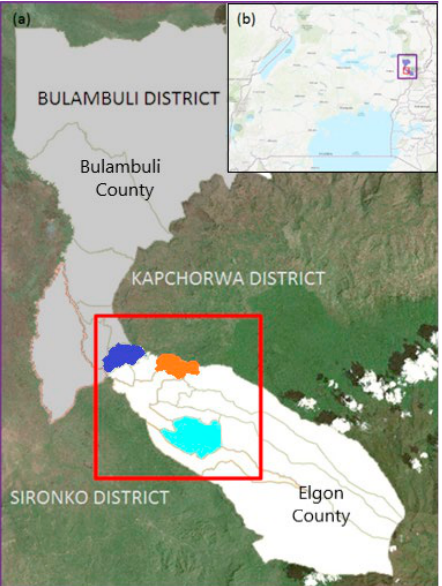
Figure 1. Map of (b) South Uganda and (a) details of Bulambuli district with Bulambuli County (grey) and Elgon County (white) with the sub-counties Bulegeni (blue), Simu (turquoise), and Namisuni